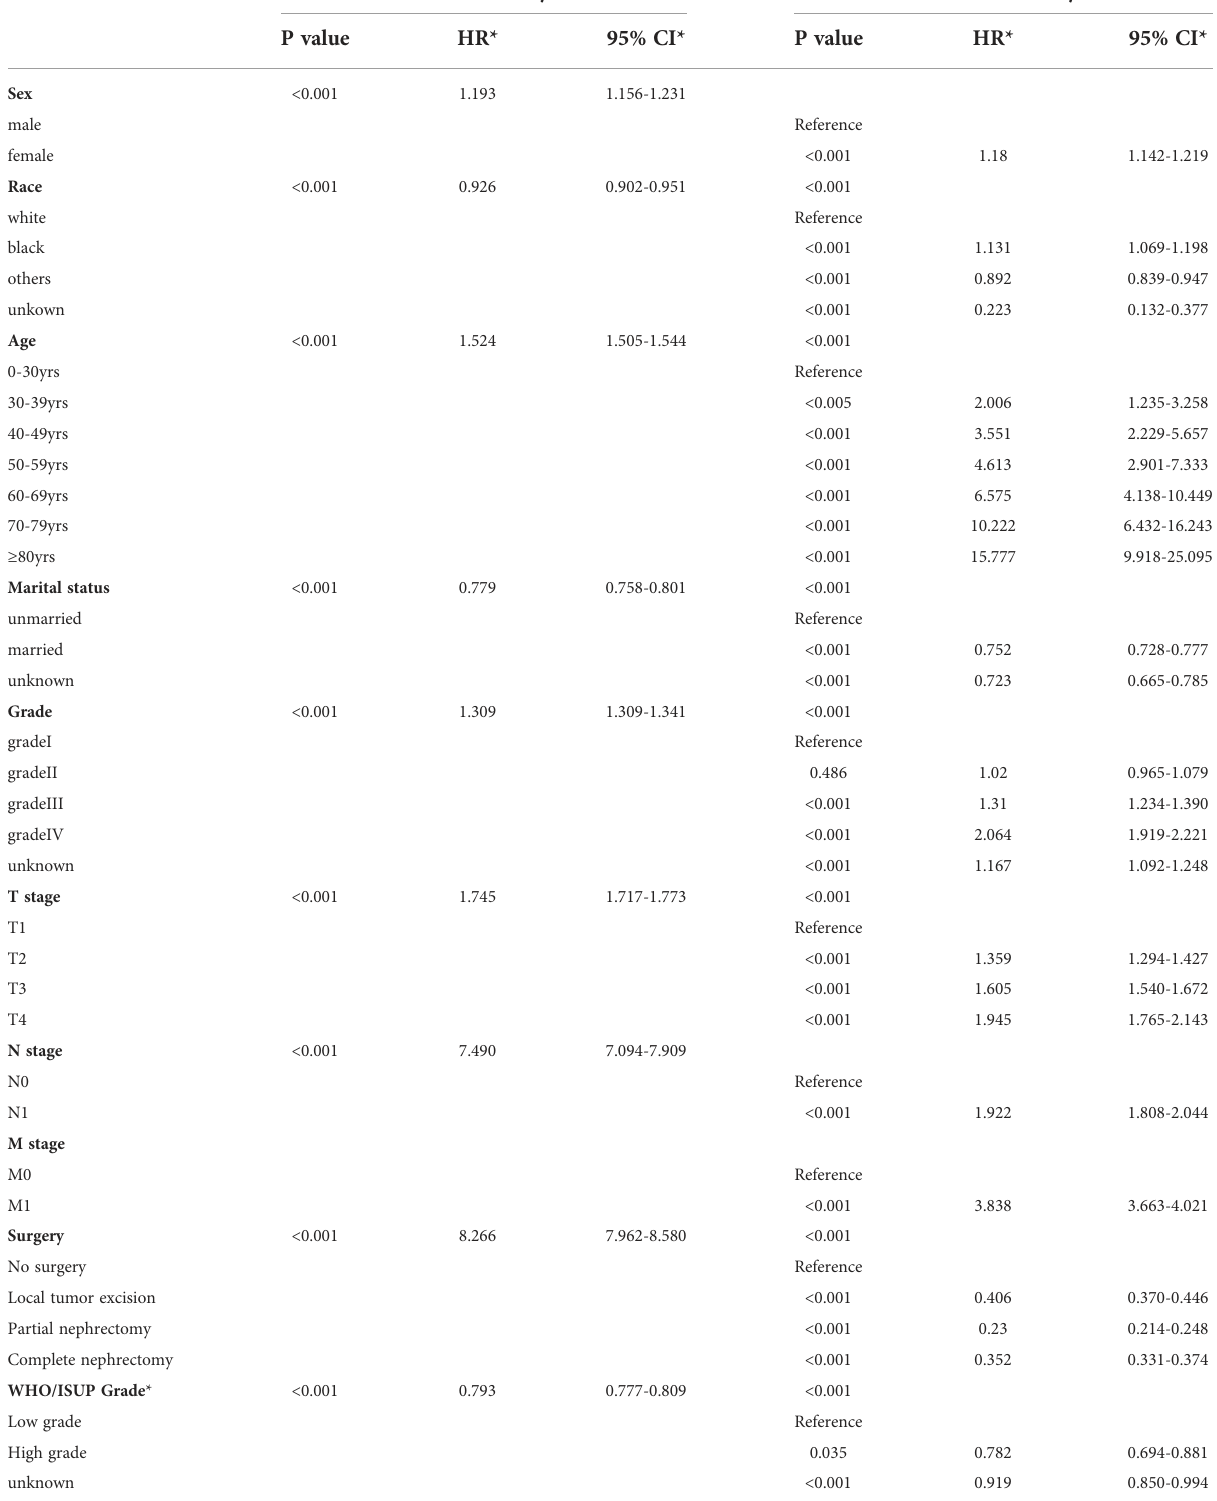
TABLE 2 Uni- and Multivariate Cox Regression Analysis of OS